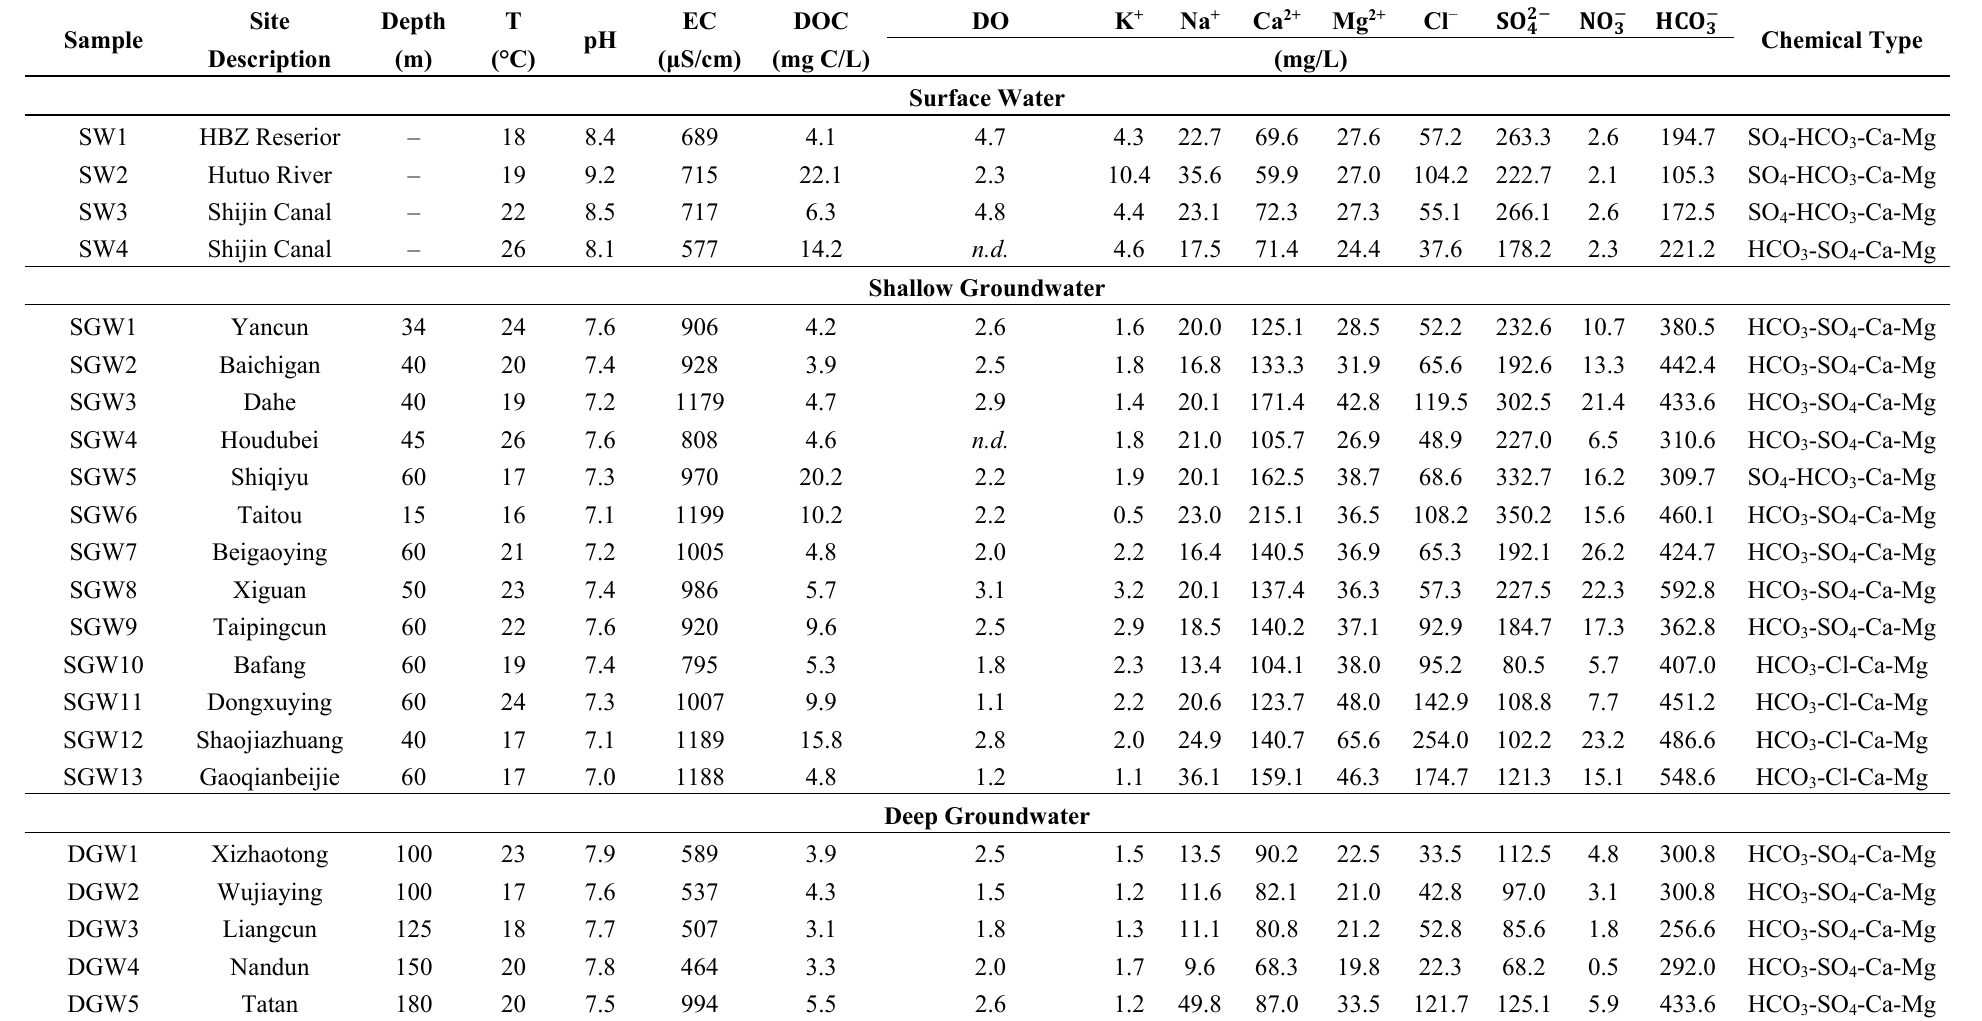
Table 1. Chemical compositions and field data of the surface water and groundwater in